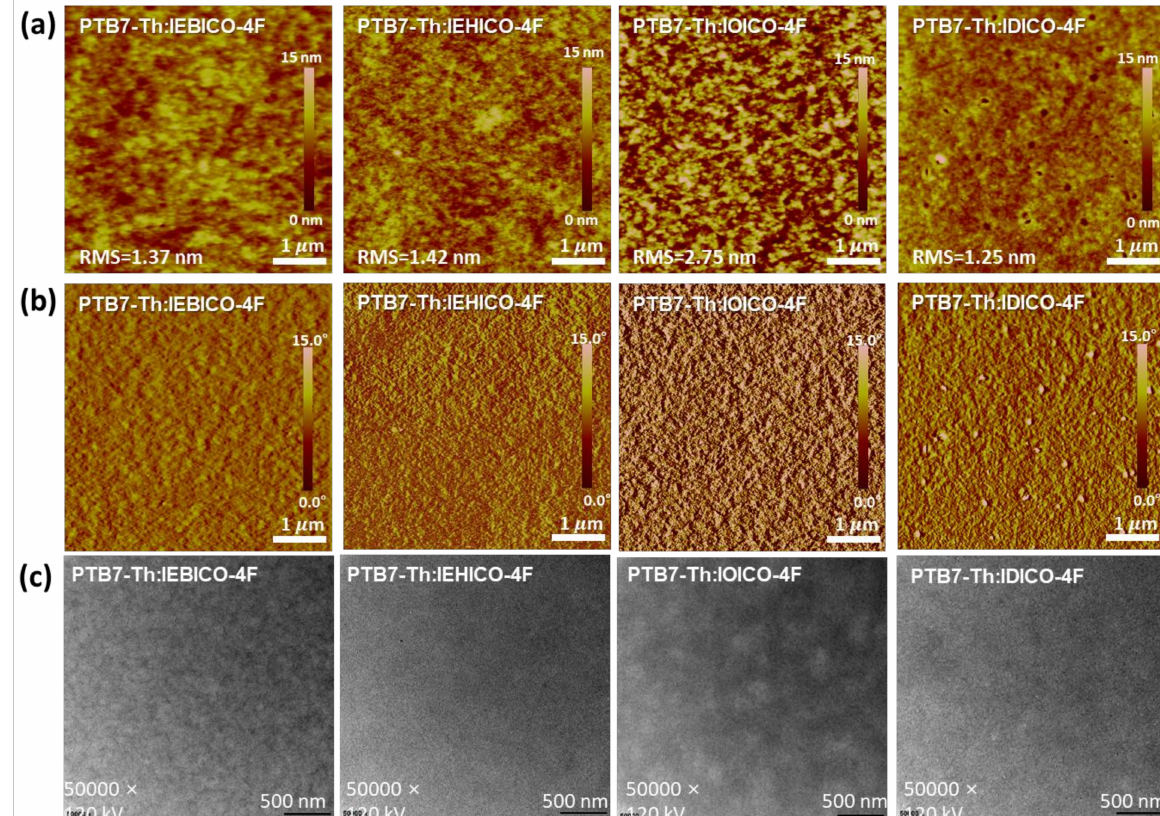
Figure 4. ( a ) Height, ( b ) phase images, and ( c ) TEM images of PTB7-Th:IRICO-4F blend films. The neat and blend films were subjected to two-dimensional grazing incidence wide- angle X-ray scattering (GIWAXS) measurements to investigate the molecular packing and orientation of IRICO-4F molecules. The GIWAXS images and the line-cut profiles are shown in Figure 5a,c respectively, for the IEBICO-4F, IEHICO-4F, IOICO-4F, and IDICO-4F neat films. The (100) scattering peak of the IEBICO-4F molecule is located at q z = 0.35 Å − 1 ( d = 17.85 Å) in the out-of-plane (OOP) direction, which corresponds to a lamellar stacking peak. The (010) peak corresponding to the π — π stacking is located at q y =